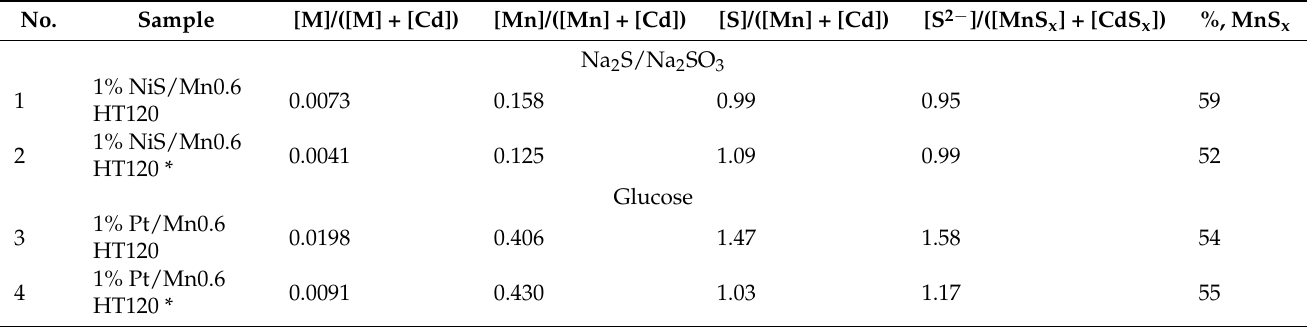
Table 5. Atomic ratios of elements in the near-surface layer of samples according to XPS data.